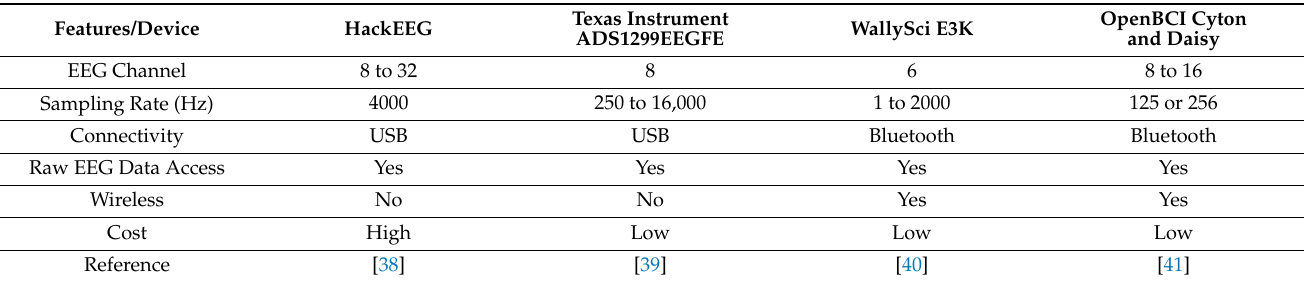
Table 1. EEG DAQ boards